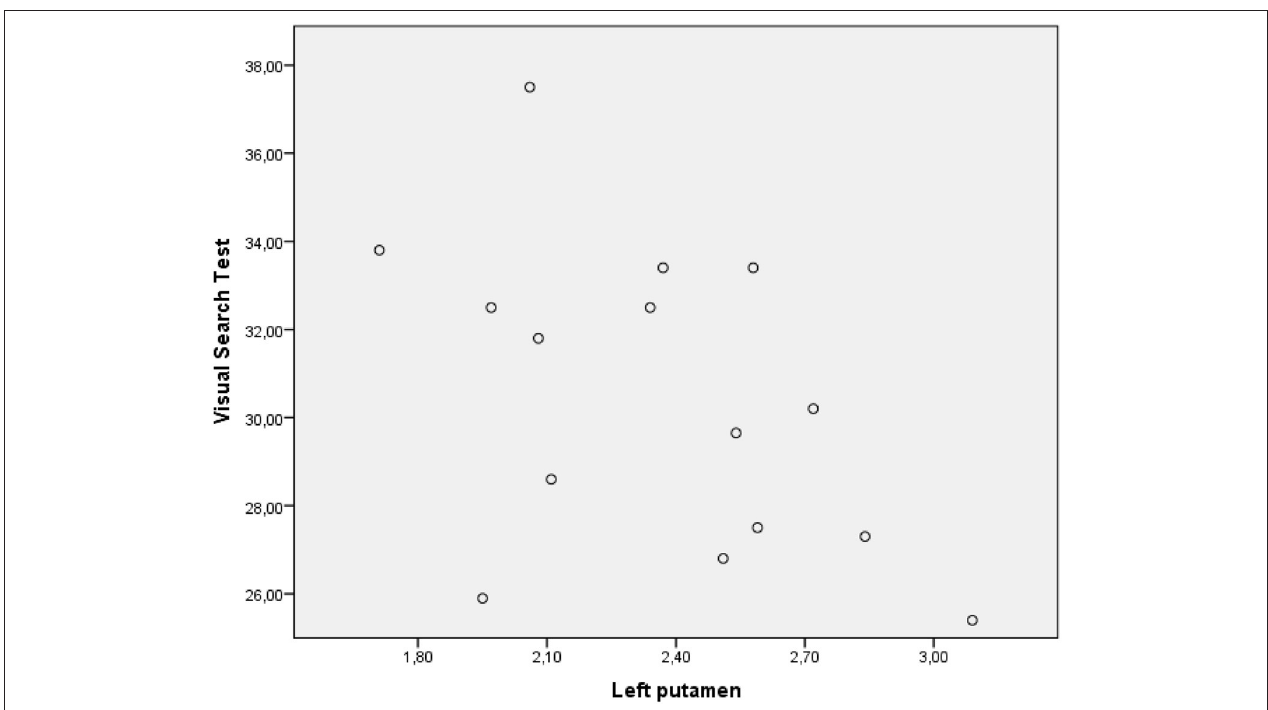
FIGURE 3 | Graphic representation of correlation between VST scores and 123I-FP-CIT binding in the left putamen